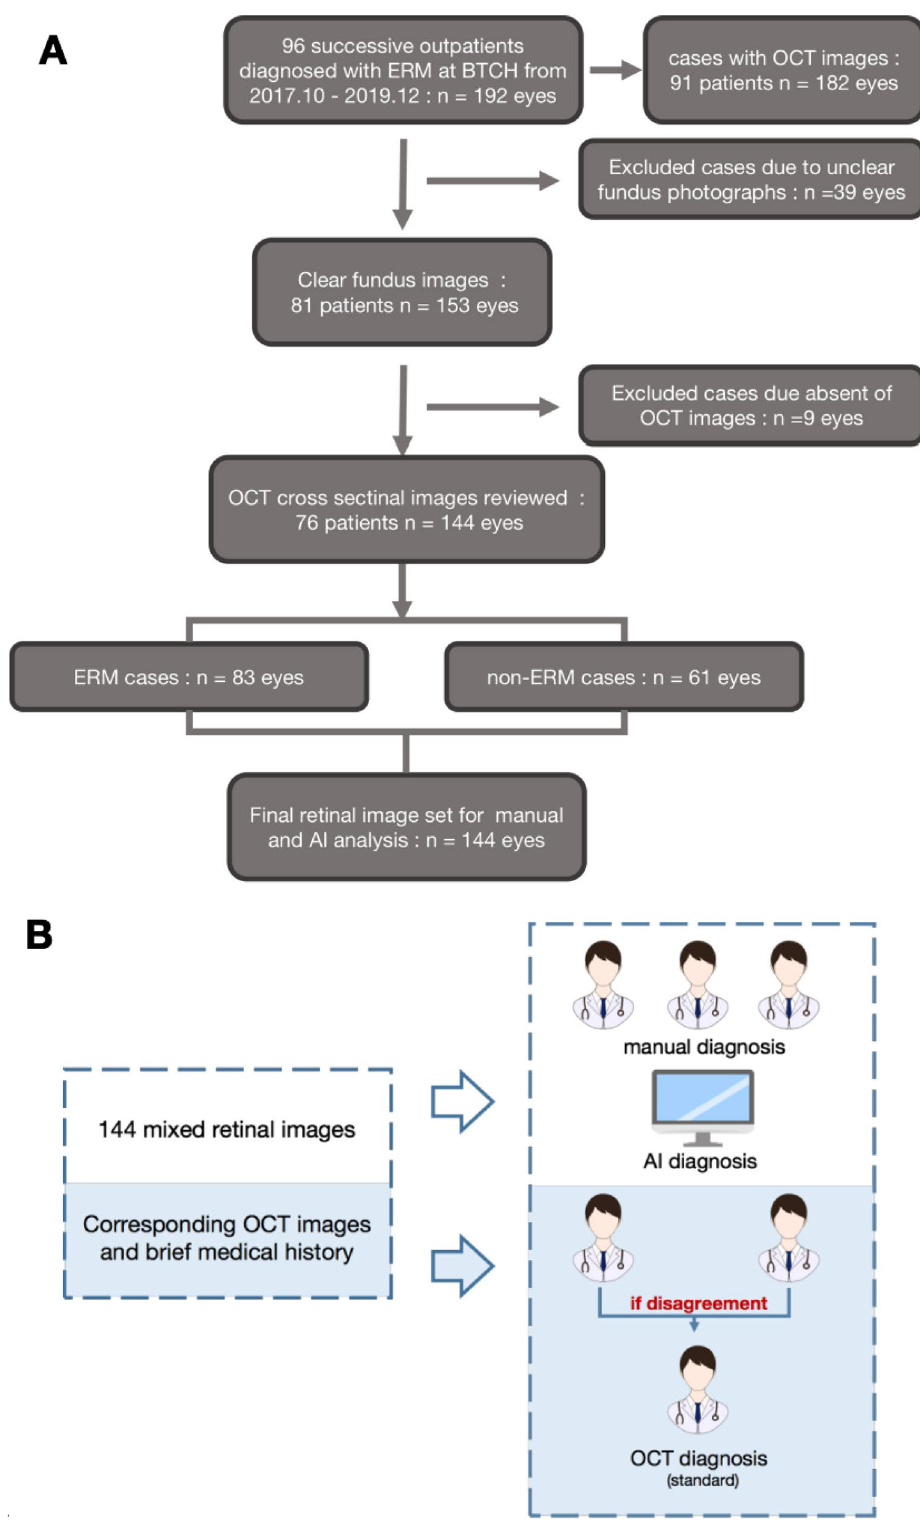
Figure 1. Experimental design. ( A ) Inclusion and exclusion of ERM case and non-ERM sex and age matched group are demonstrated in the flow chart. ( B ) Simultaneously, mixed retinal image set were evaluated by 3 ophthalmologists and AI model respectively. Result from manual diagnosis and AI model were compared with standard OCT diagnosis. ERM epiretinal membrane, BTCH Beijing Tsinghua Changguang